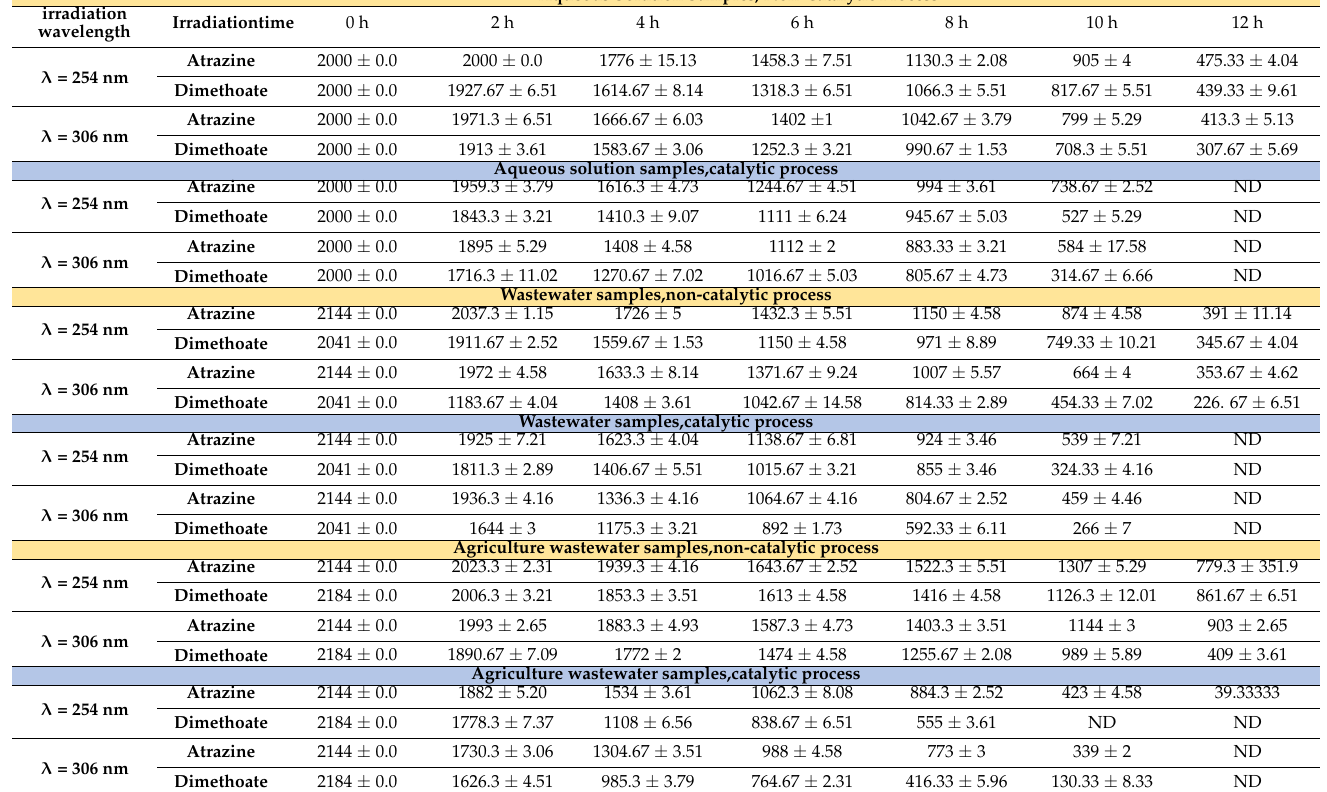
Table 3. Mean of concentration of pesticide residues degradation (R(ppb)) at two different wavelengths and irradiation time in the presence and absence of a catalyst ( ± standard deviation (SD)). (spiked with 2000 PPb) and for catalytic process: 0.001 gm TiO 2 /10